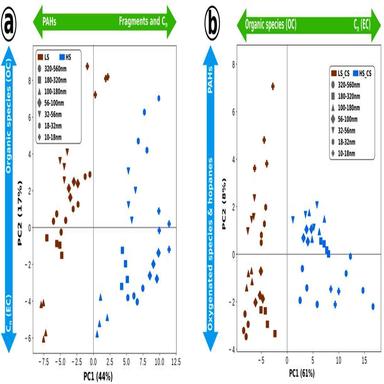
Score plot of the first two principal components obtained from the mass spectra of size-selected particles collected in the LS and HS engine regimes without (a) and with (b) the catalytic stripper. The arrows indicate the meaning of principal components obtained from their corresponding loadings.